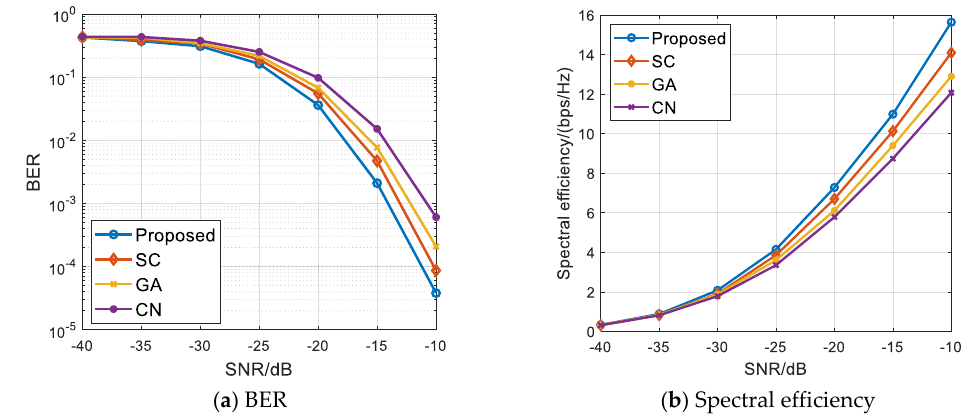
N = .( a ) BER of all the algorithms; ( b ) Spectral t